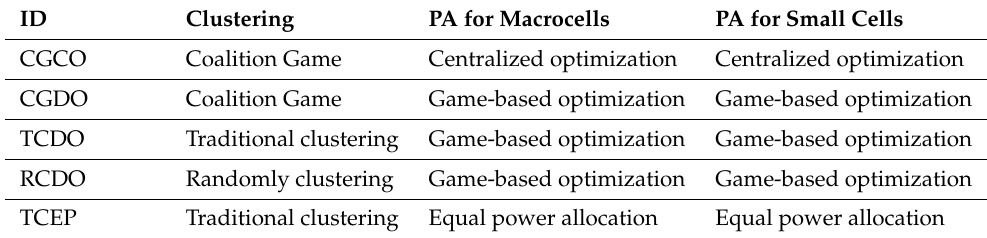
Table 4. ID of strategies for